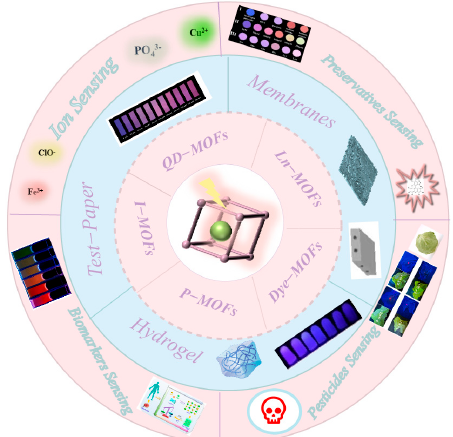
Figure 1. Schematic illustration of the fluorescent characteristics and sensing applications of LG@MOFs. Major types of luminescent guest (LG) that have been encapsulated inside MOF hosts are summarized. 2. Synthetic Protocols and Design Guidelines The structure and performance of LG@MOF systems are significantly impacted by the synthetic methods used. The syntheses of this family of LG-encapsulated systems, can currently be classified into two main categories, including “post-synthesis” and “in situ synthesis”